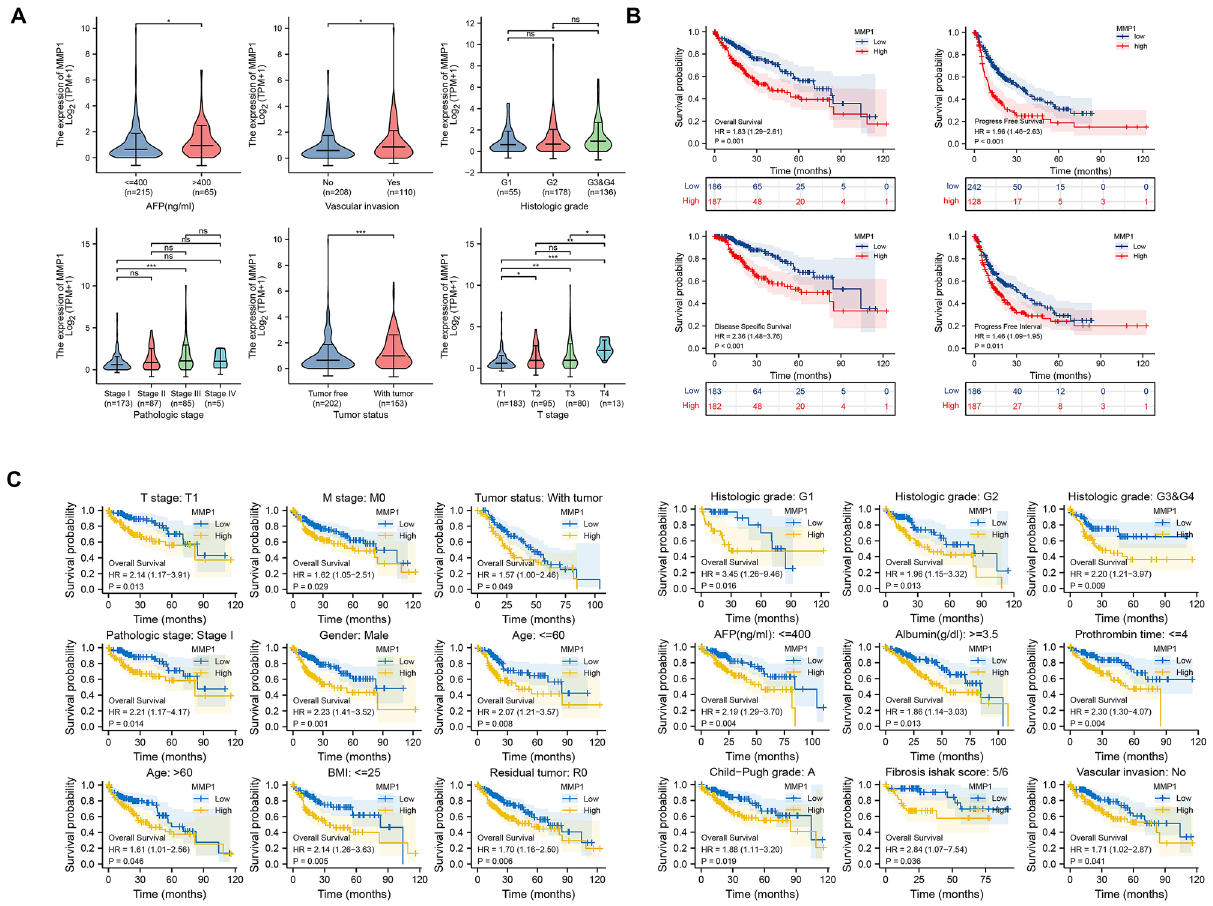
Figure 6. Clinical correlation and prognosis analysis of MMP1 expression in TCGA-LIHC. ( A ) Correlation analysis between multiple clinical indicators and MMP1 expression; ( B ) Prognosis analysis of MMP1 expression in TCGA-LIHC; ( C ) A series of subgroup analyses on OS of MMP1 expression in TCGA-LIHC. OS, overall survival, * P < 0.05, ** P < 0.01, *** P < 0.001. Characteristics Total(N) Odds Ratio (OR) P